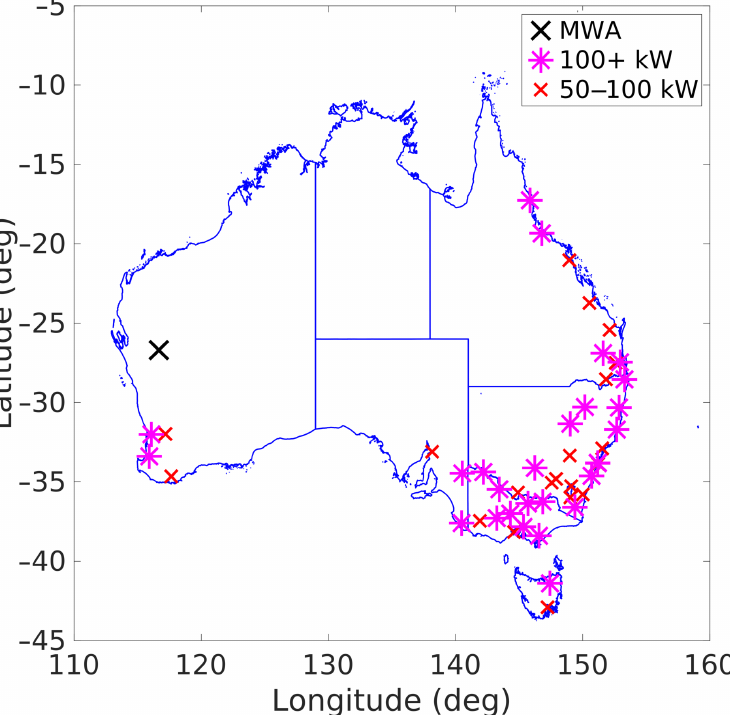
Figure 6. A map of all the powerful (greater than 50 kW) FM radio transmitters in